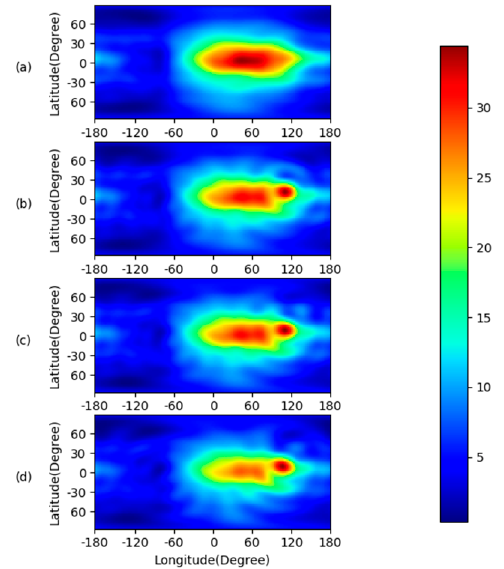
Figure 5. Ionospheric VTEC map (UT 6:00, DOY 78, 2020) of CNES ( a ), RRTGIM-1 ( b ), RRTGIM-3 ( c ), and RRTGIM-6 ( d ).